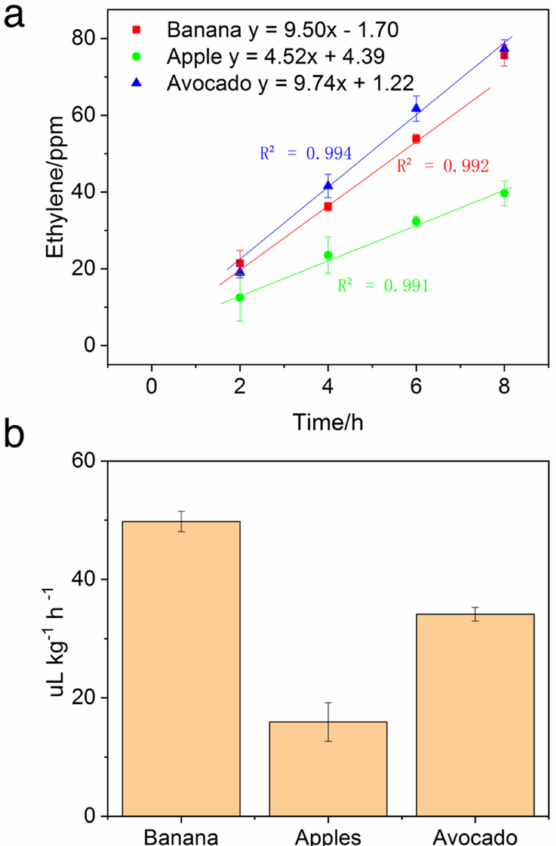
Figure 6. ( a ) SOFS detected ethylene release by fruits during the ripening process at different incubation periods. ( b ) Ethylene releasing rates of different fruits over 8